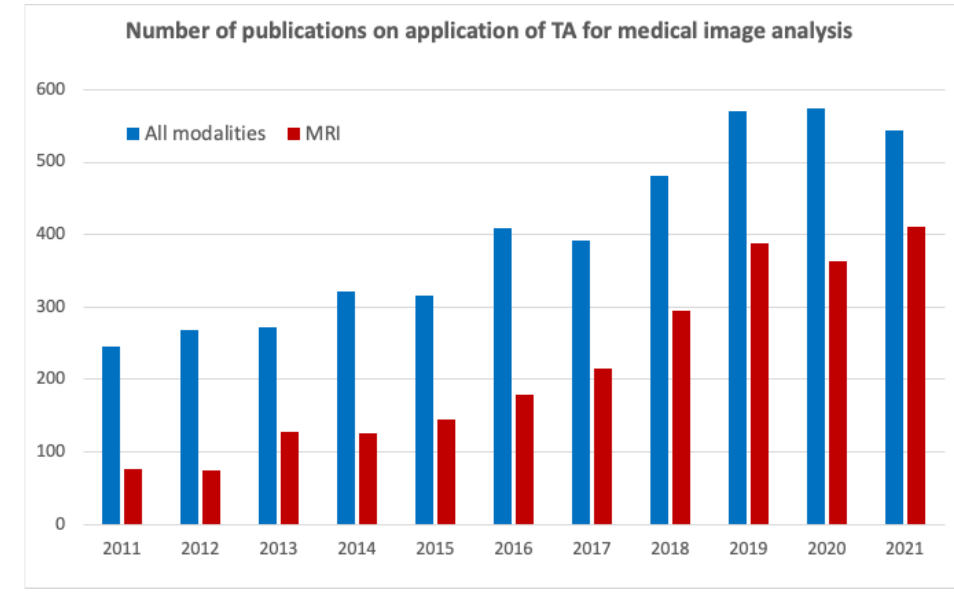
Figure 3. Number of publications on TA of medical images according to the Scopus database (accessed on February 01, 2022, www.scopus.com).